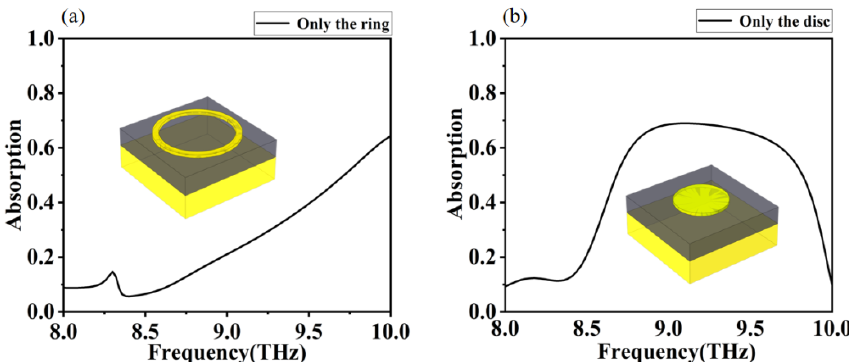
Figure 3. Absorption simulation curves of the absorber with different structures: ( a ) only the ring, ( b ) only the disc.